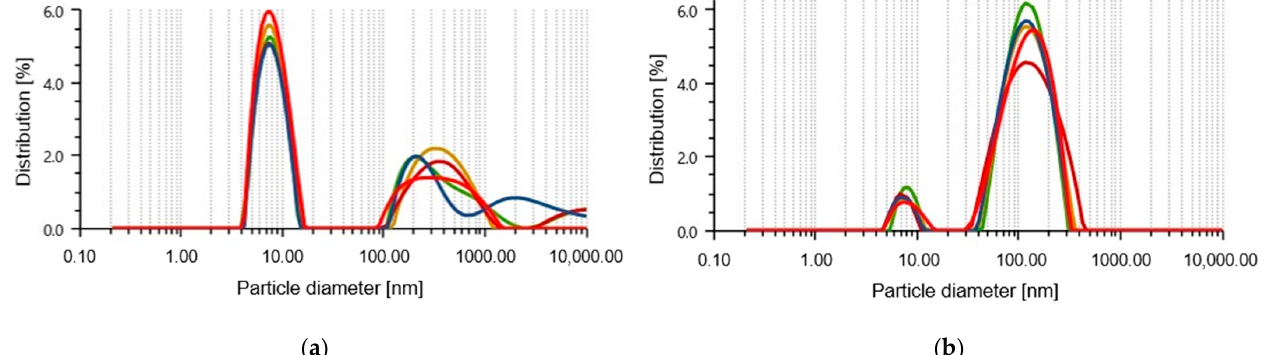
Table 2. Size of selenium nanoparticles (SeNPs) synthesized with extracts of different plant species. Figure 1. Size of selenium nanoparticles (SeNPs). ( a ) Nanoparticles synthesized with extracts of